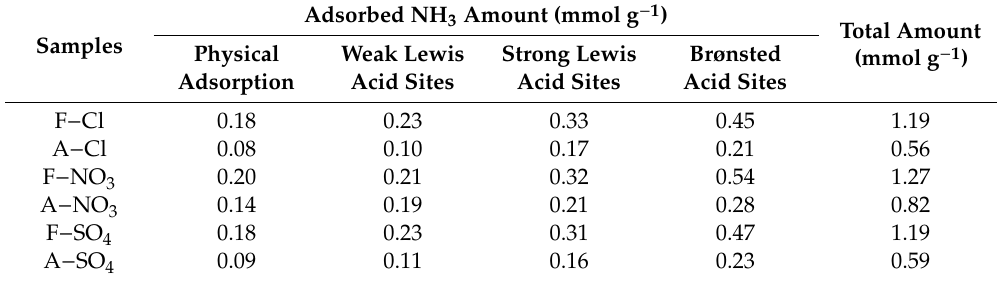
Figure 4. Ammonia temperature-programmed desorption (NH 3 − TPD) profiles of Cu II − SSZ − 13 catalysts before ( a ) and after ( b ) hydrothermal aging treatment. Table 4. The adsorbed NH 3 amount of Cu II − SSZ − 13 catalysts before and after hydrothermal aging treatment.